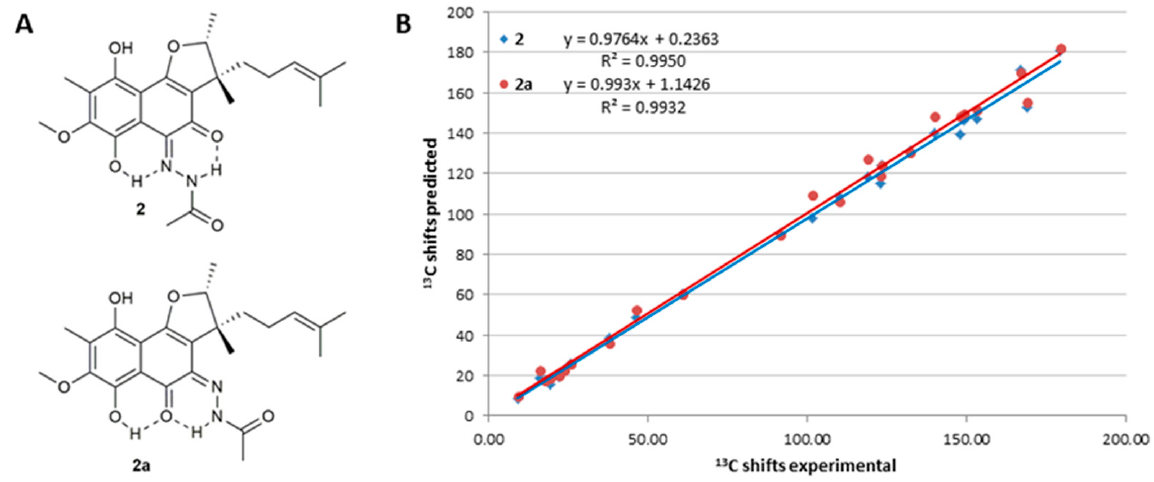
Figure 2. Comparison of the predicted 13C NMR shifts from ACD labs of the two possible furaquinocin L isomers 2 and 2a ( A ) with the experimentally determined data ( B ).